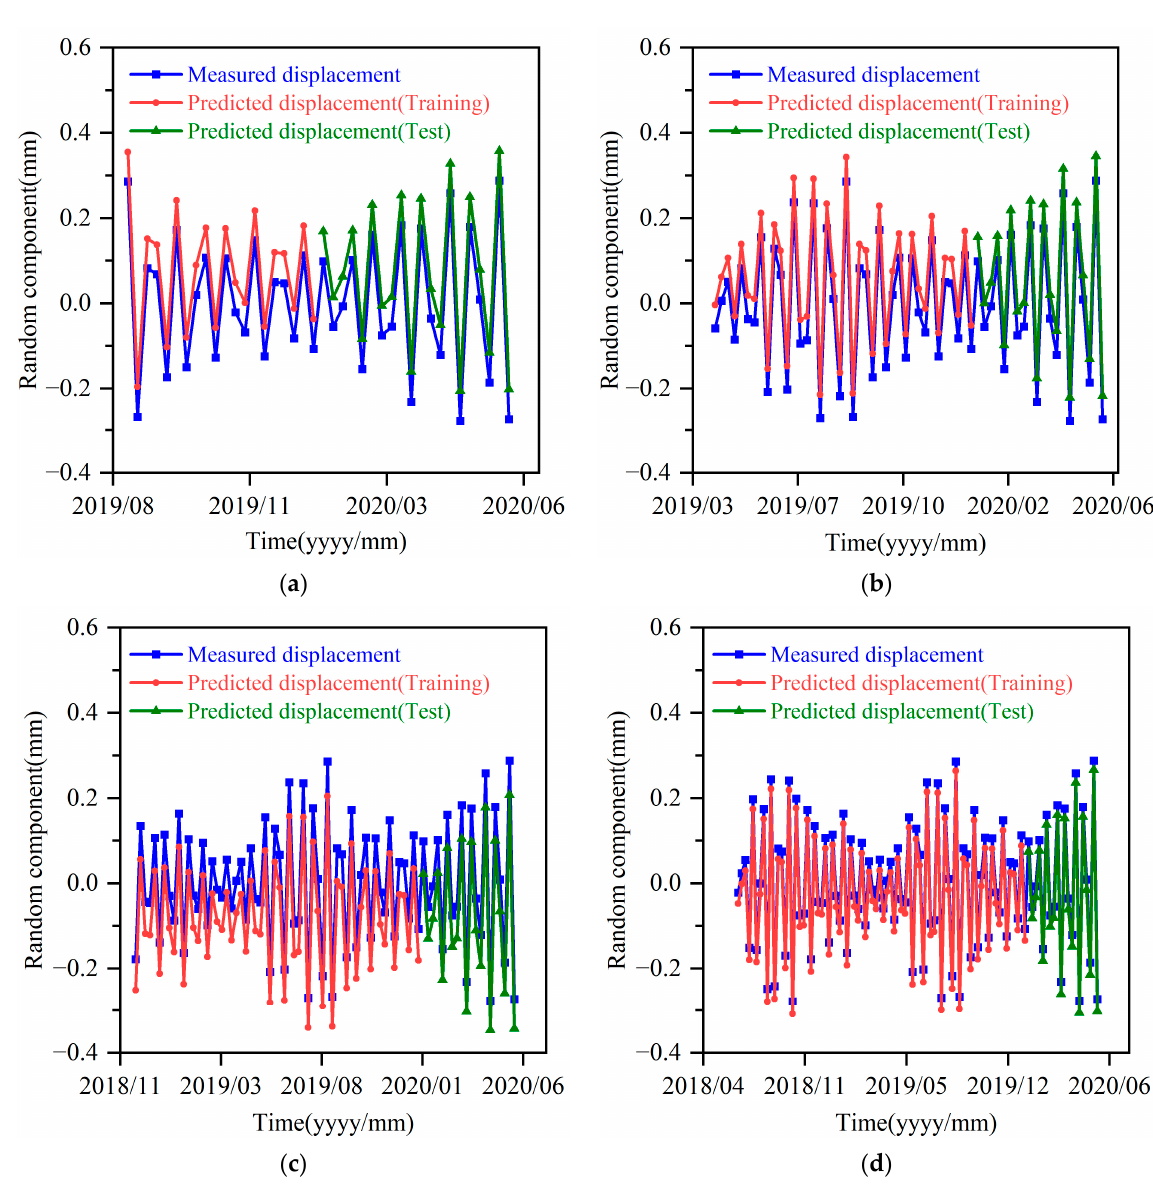
Figure 10. Random displacement prediction results of different training sets: ( a ) prediction results of Model 1; ( b ) prediction results of Model 2; ( c ) prediction results of Model 3; ( d ) prediction results of Model 4.